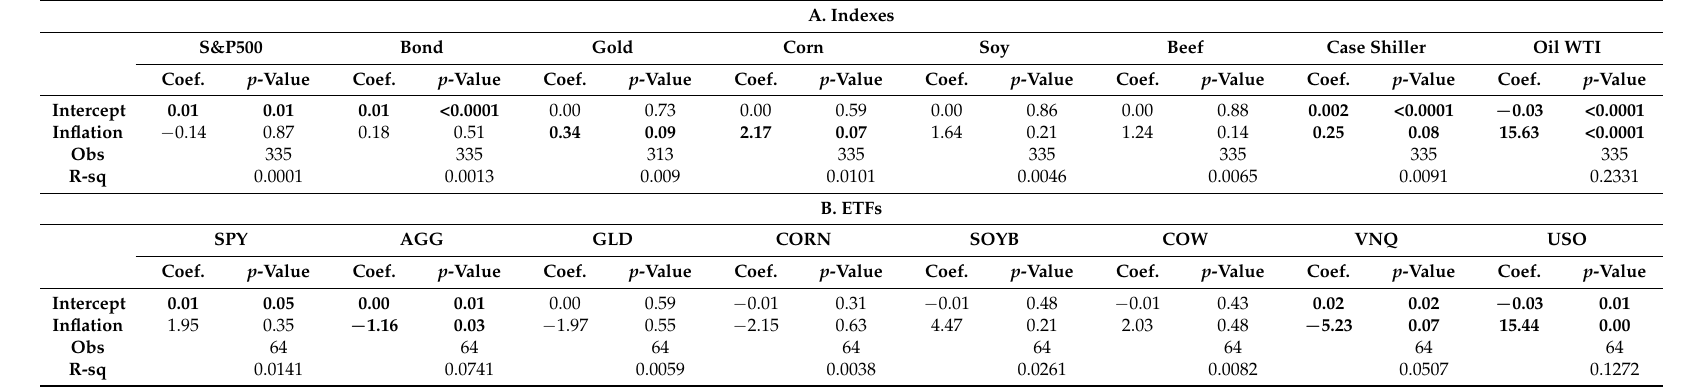
Table 4. Regression results table.